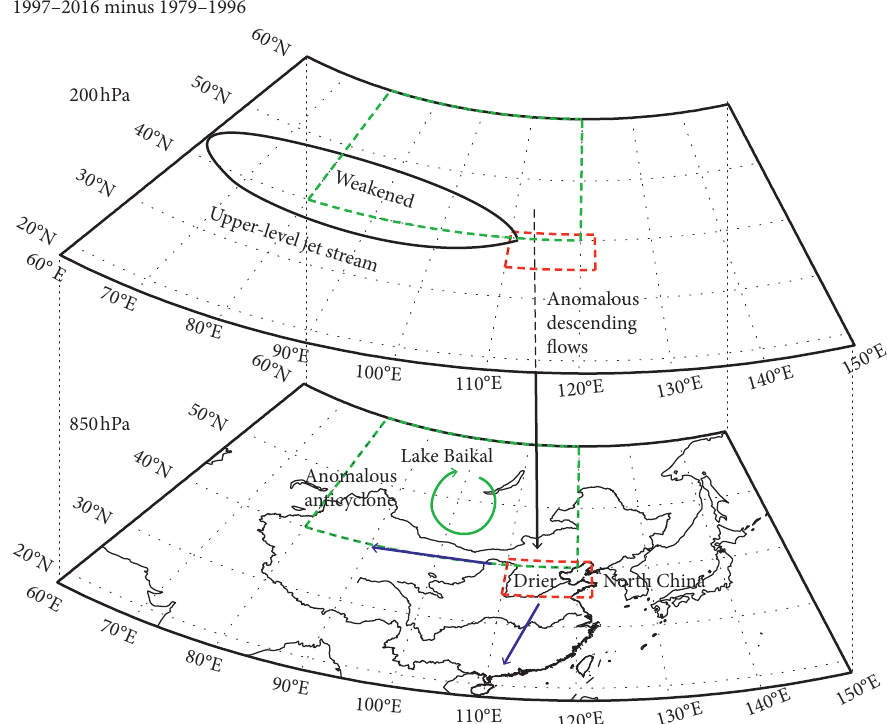
Figure 11: Schematic diagram of mechanism for the halt of the increasing trend of summer rainfall over North China since the